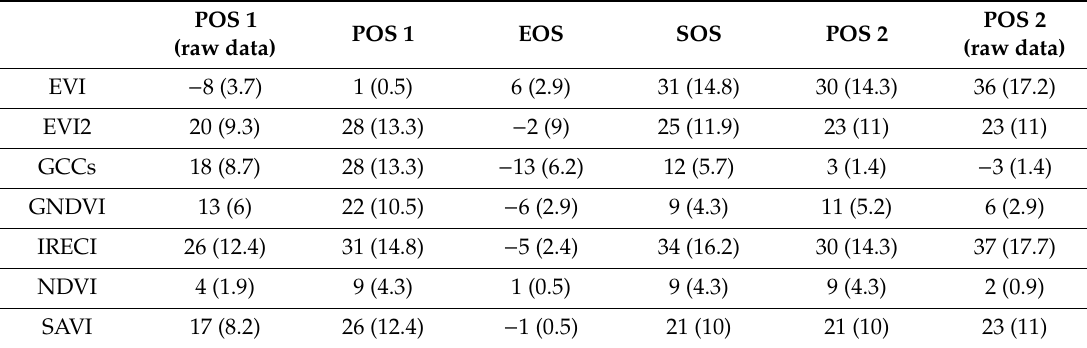
Table 3. Biases in days of the phenological parameters extracted from satellite vegetation indices with respect to GCCc, for POS 1, EOS, SOS and POS 2. The percentage of error with respect to the whole cycle is displayed in parentheses.